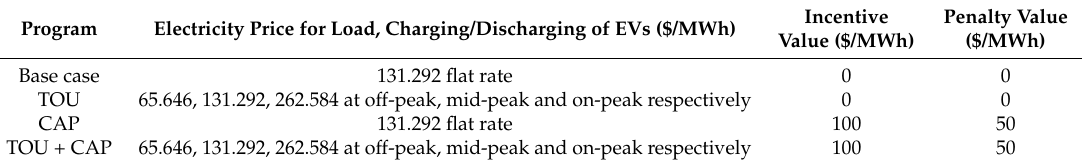
Table 5. The case considering PBDR and IBDR for operational scheduling of SDISCO. CAP, capacity market program.